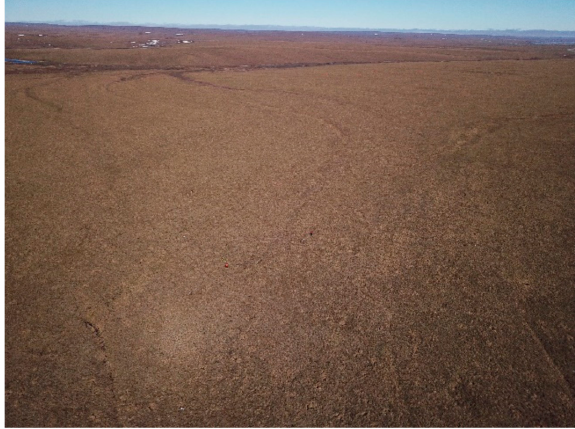
Figure A6. Oblique aerial photo of IC on 31 May